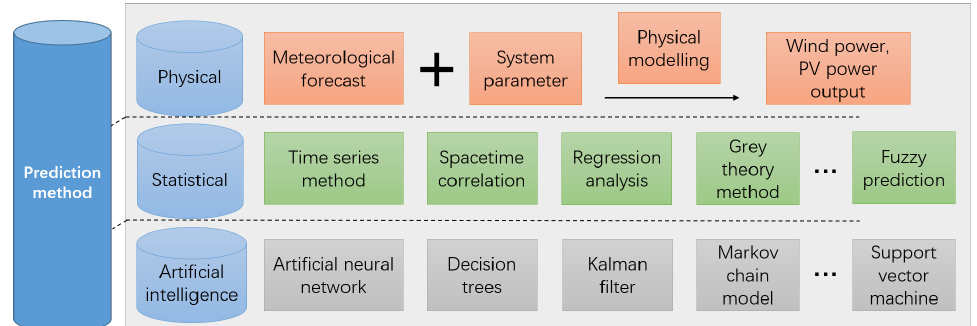
Figure 6. Prediction method classification of wind and PV power